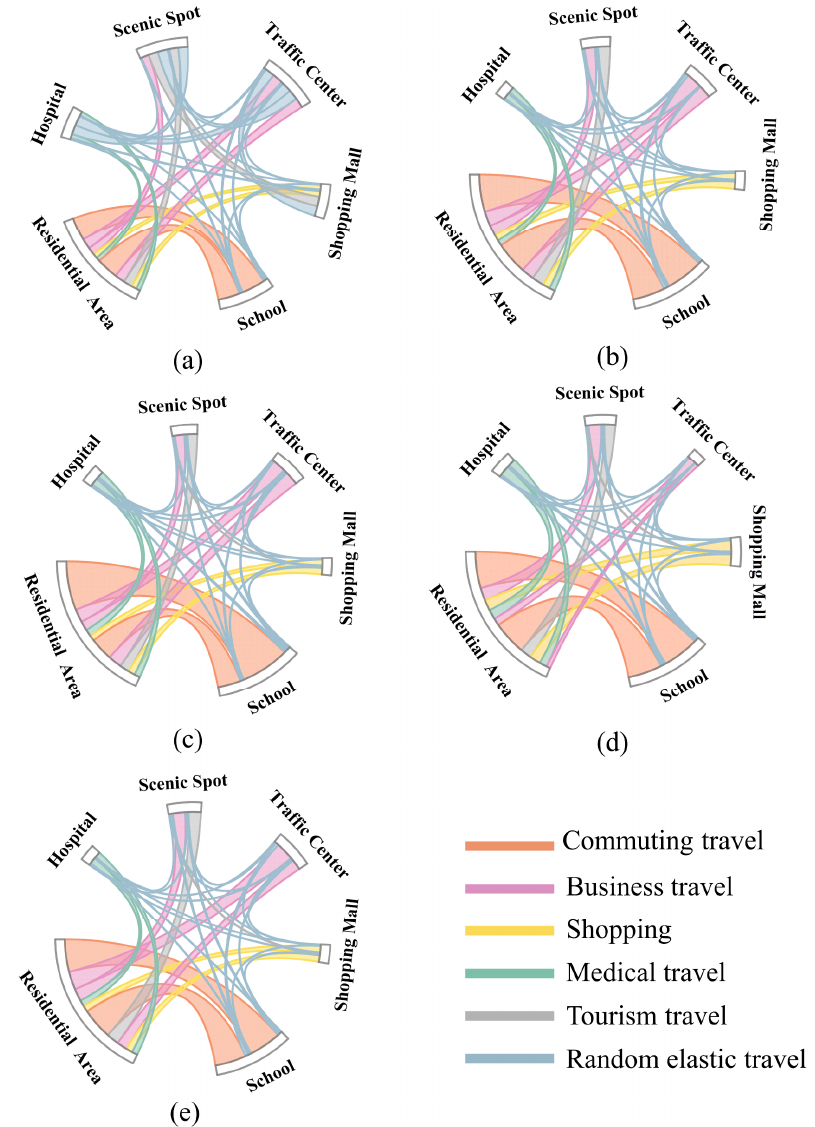
Figure 10. Residential travel flow in ( a ) normal period of society, ( b ) early period of COVID-19, ( c ) outbreak period of COVID-19, ( d ) rework period of society, and ( e ) recovery period of society.